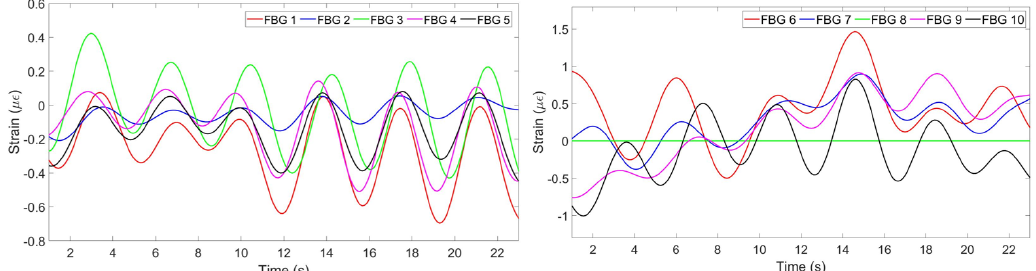
Figure 8. Strain pattern after reflecting opposite patterns and neglecting wrong patterns detected by 5 FBGs on the chest ( left ) and by 5 FBGs on the abdomen ( right ).